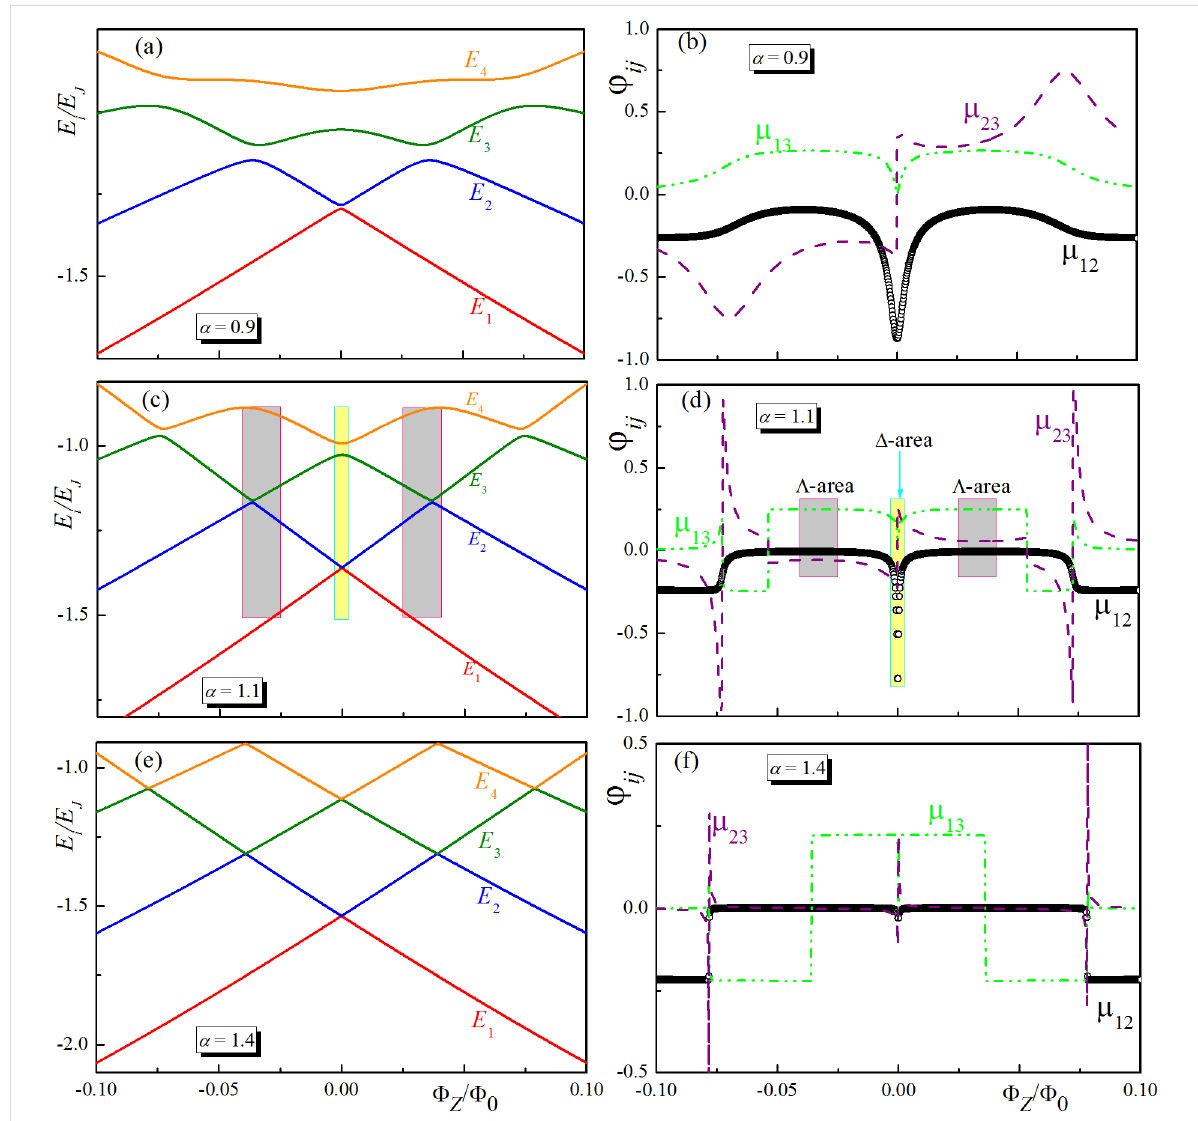
Figure 6: Eigenvalues, E 1,2,3,4 , of the unperturbed Hamiltonian and matrix elements ( μ ij ) for transitions between its eigenstates for different values of the potential barrier between the wells: α = 0.9 (a, b), α = 1.1 (c, d), and α = 1.4